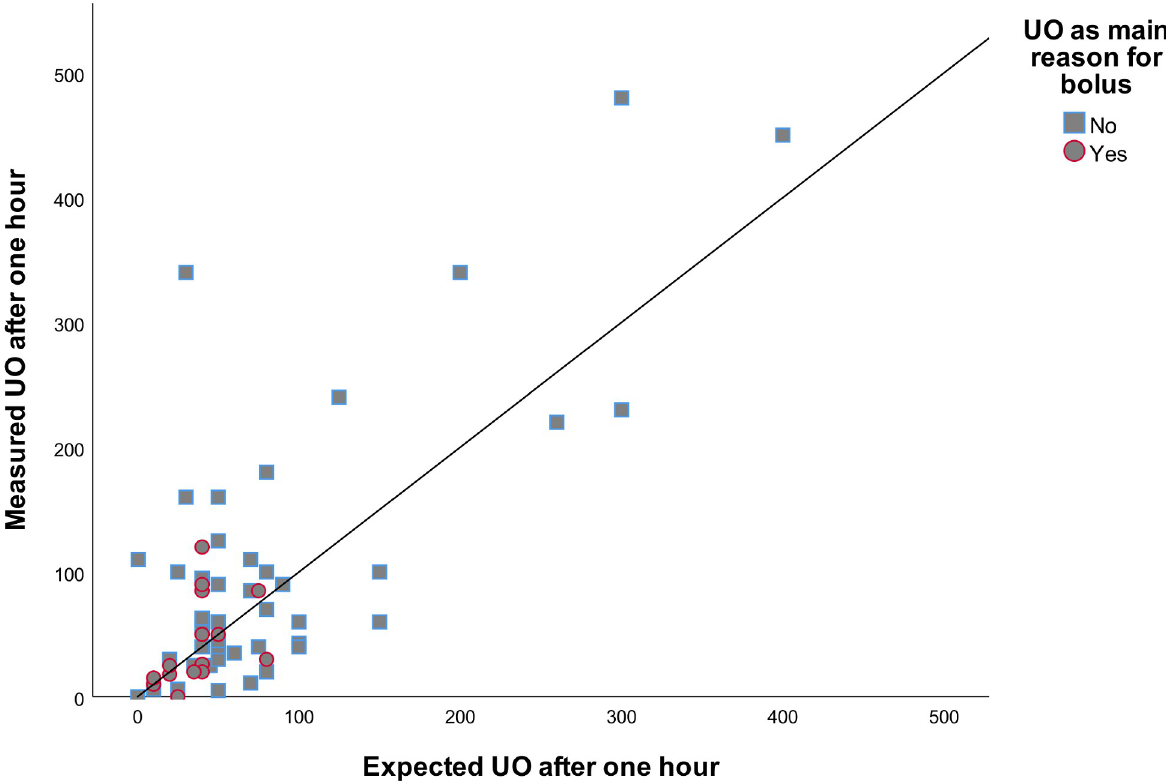
Fig 3. Scatter plot of measured and expected UO one hour after fluid bolus. Scatter plot comparing measured and expected UO one hour after fluid bolus. Line represents perfect fit. UO = Urine output.